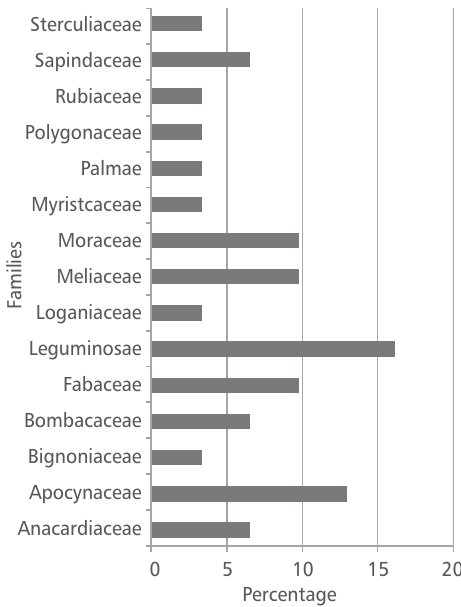
FIGURE 2. The distribution of the M. excelsa ’s associates by family